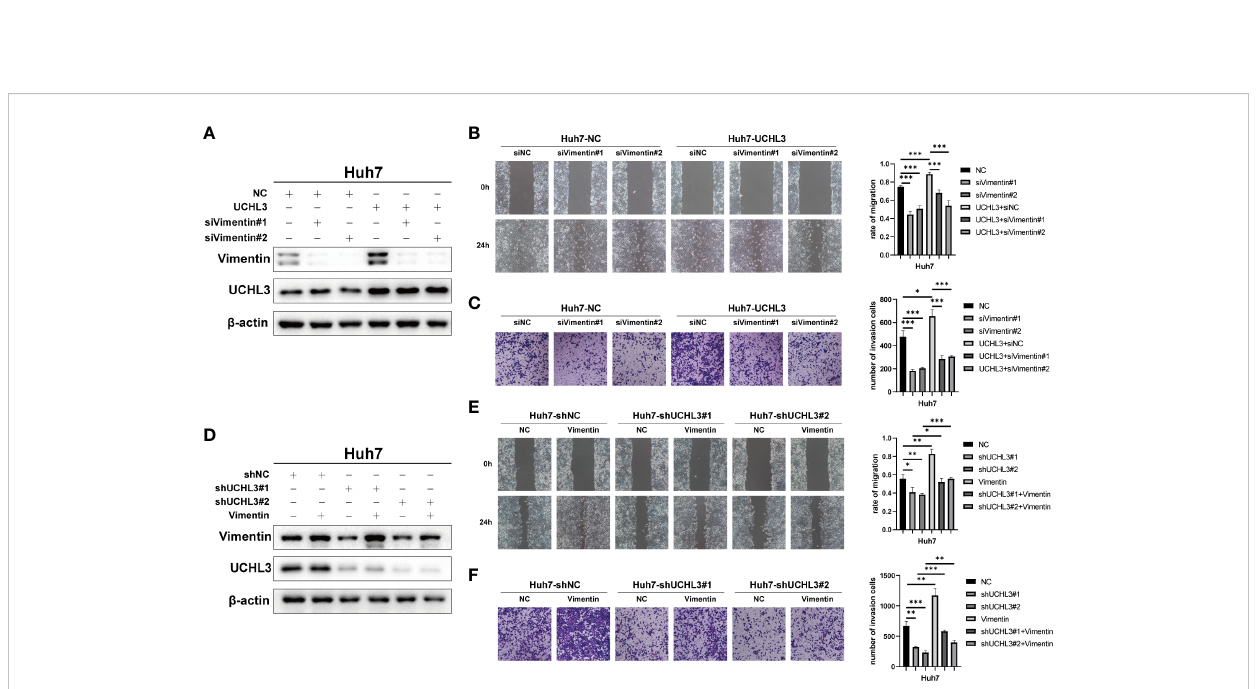
FIGURE 6 UCHL3 facilitated HCC cell migration through regulating Vimentin. (A) Overexpression of UCHL3 and knockdown of Vimentin in Huh7 cells shown by Western blotting. (B) Vimentin knockdown abolished the increased cell migration induced by UCHL3 overexpression, as shown by wound healing assays. (C) Vimentin knockdown abolished the increased cell migration induced by UCHL3 overexpression, as shown by Transwell assays. (D) Knockdown of UCHL3 and overexpression of Vimentin in Huh7 cells shown by Western blotting. (E) Vimentin overexpression reversed the inhibition of cell migration caused by UCHL3 knockdown, as shown by wound healing assays. (F) Vimentin overexpression reversed the inhibition of cell migration caused by UCHL3 knockdown, as shown by Transwell assays. *p < 0.05, **p < 0.01, ***p <